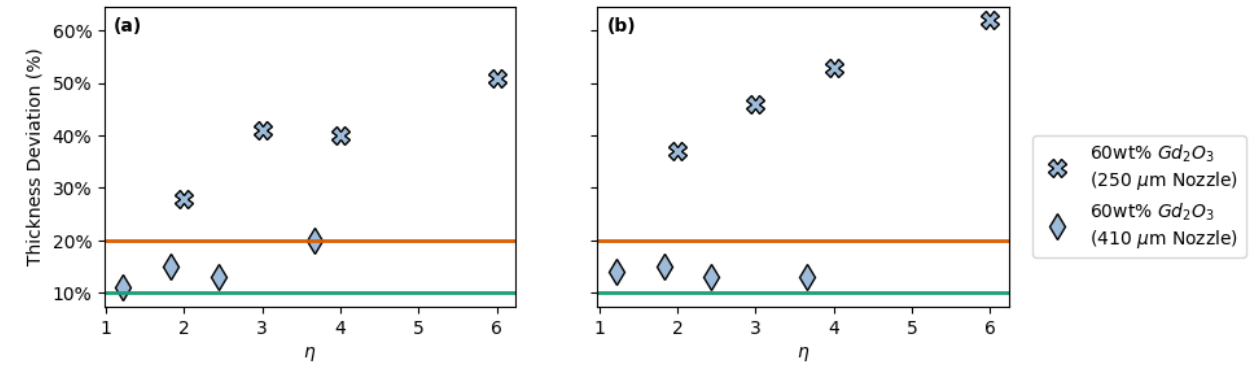
Figure 4. Overall thickness deviation vs. spacing ratio ( η ) for prints with: ( a ) FCT geometries and ( b ) SC geometries. * Data in plot ( a ) from Brounstein et al. [19].